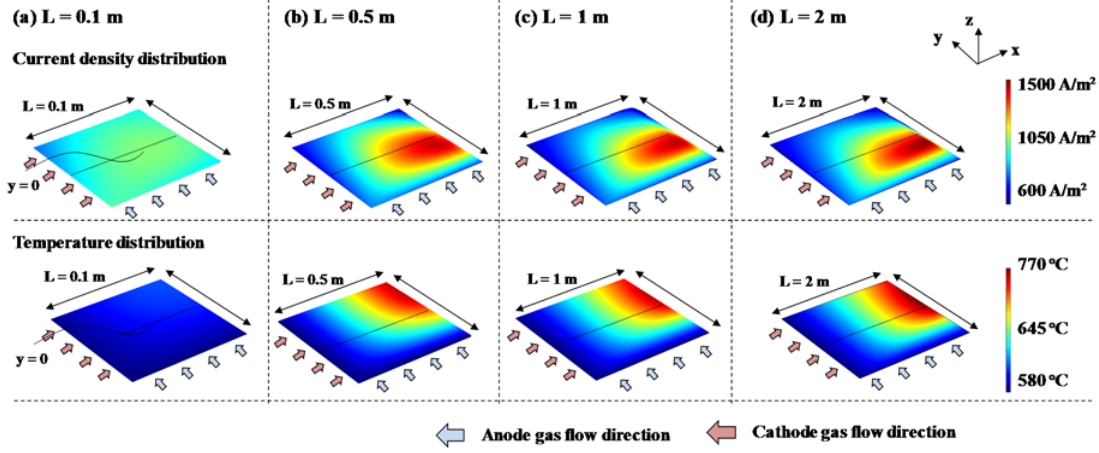
Figure 9. Current density and temperature distribution relative to the length for the cross ‐ flow type.